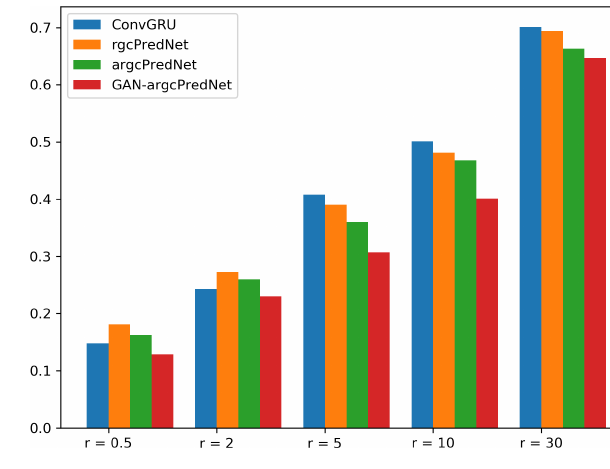
Figure 5. CSI index score.